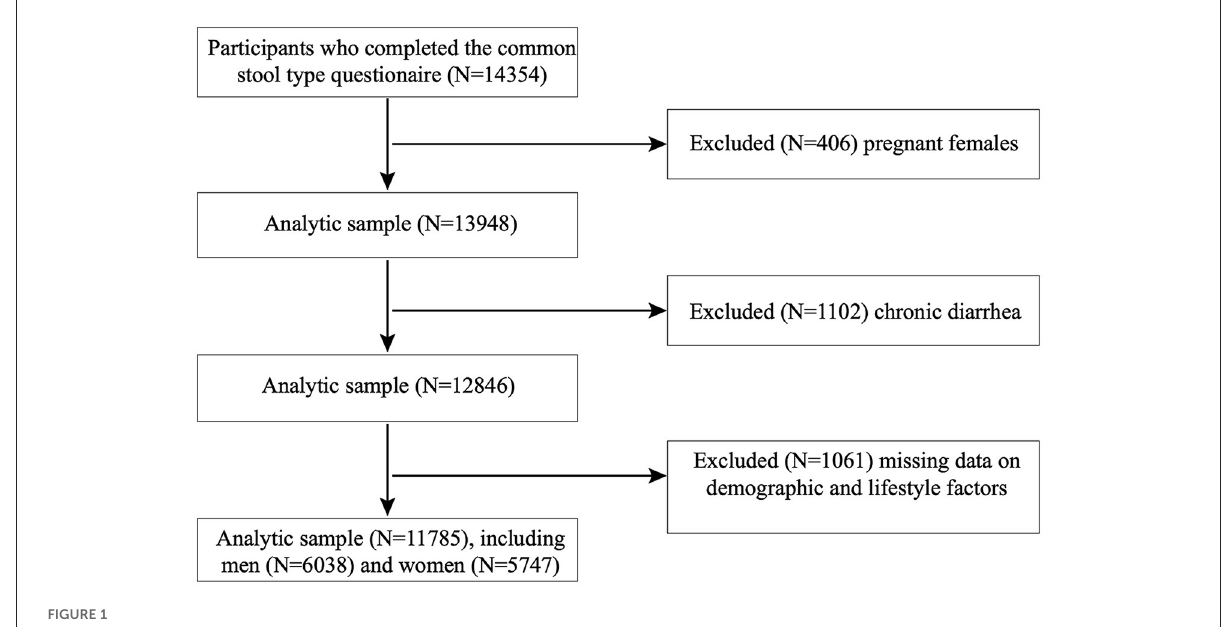
FIGURE1 Flow chart of the selection